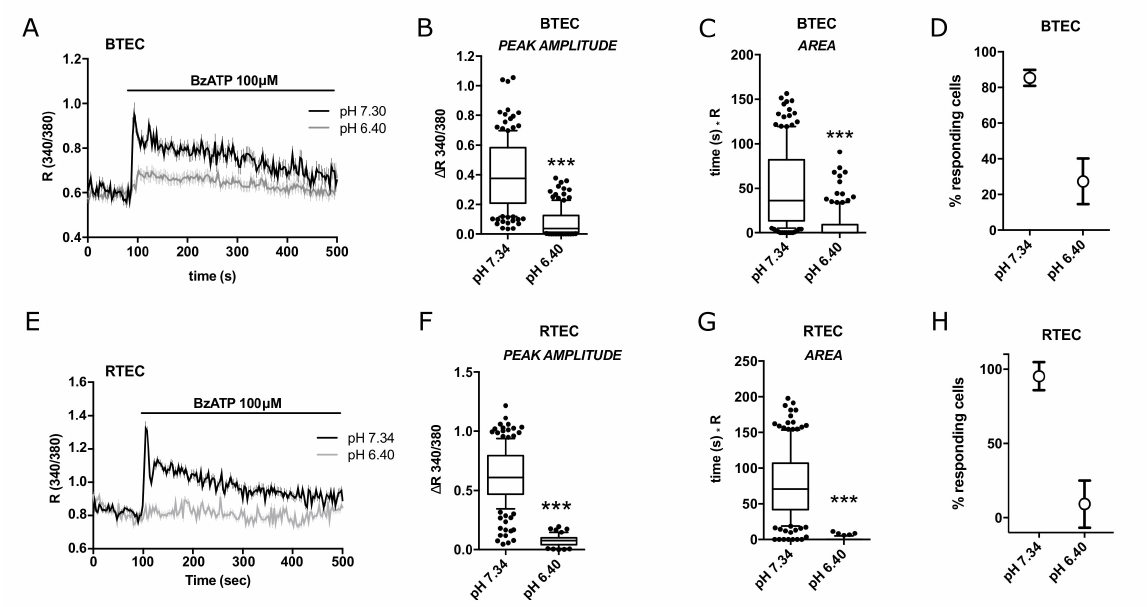
Figure 4. BzATP-triggered cytosolic calcium signals in BTEC and RTEC are modulated by extra- cellular pH. ( A ) Representative traces of 100 µ M BzATP-induced calcium signals in BTEC and ( E ) RTEC measured in physiological extracellular solution (pH 7.4; black traces) and their